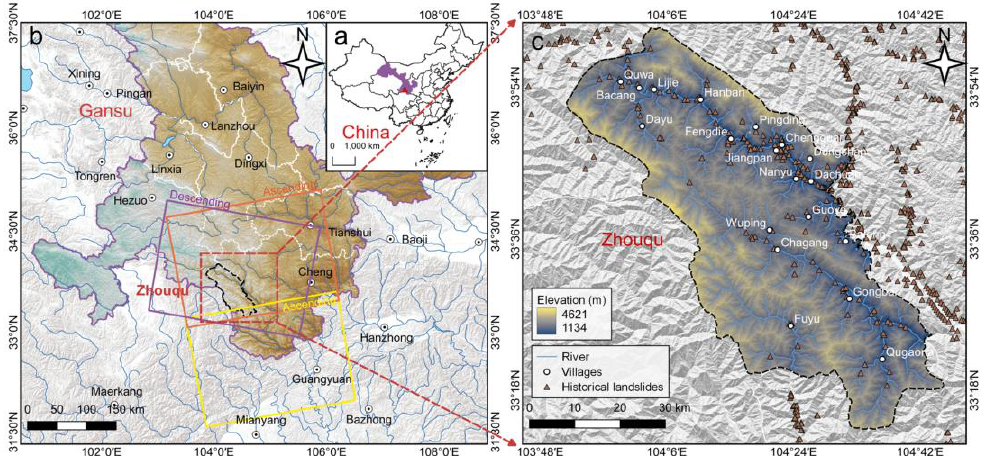
Figure 1. Location and overview of the study area: ( a ) Zhouqu is located in the southern part of Gansu Province, China; ( b ) the study area shows in ascending and descending Sentinel-1 satellite images; and ( c ) the topographic relief, rivers, and historical landslide distribution in Zhouqu.